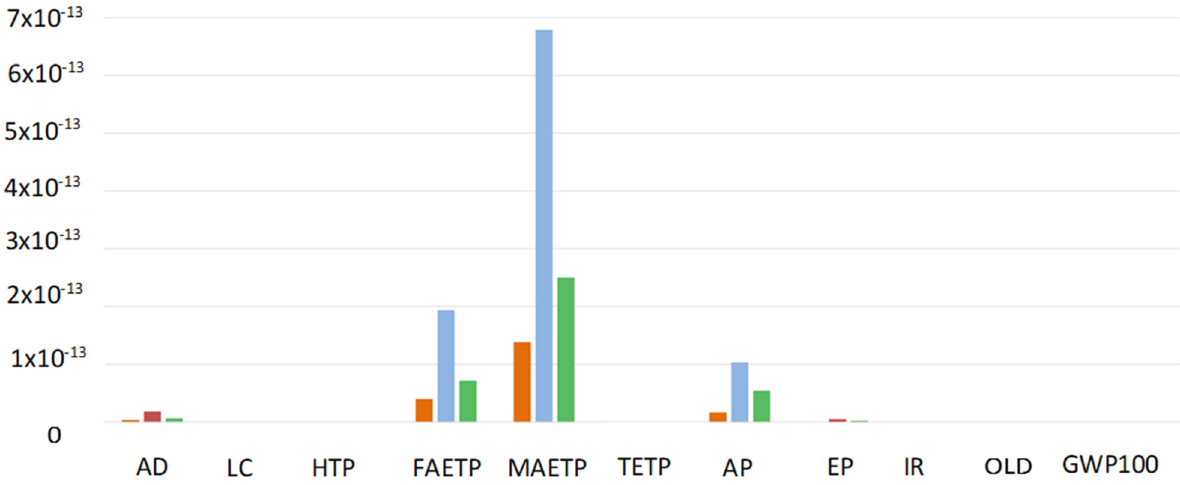
Figure 11. Normalized midpoint indicators: comparison between PEMFC Scenario A (Orange), AEMFC Scenario B (Light blue) and AEMFC Scenario C (Green). AD = Abiotic Depletion (elem., reverse base); LC = Land Competition; HTP = Human Toxicity Potential 100a; FAETP = Freshwater Aquatic Eco Toxicity Potential 100a; MAETP = Marine Aquatic Eco Toxicity Potential 100a; TETP = Terrestrial Eco Toxicity Potential 100a; AP = Acidification Potential (fate not incl.); EP = Eutrophication Potential (incl. fate); IR = Ionising Radiation; OLD = Ozone Layer Depletion (incl. NMVOC av.); GWP = Global Warming Potential 100a (incl. NMVOC av.).